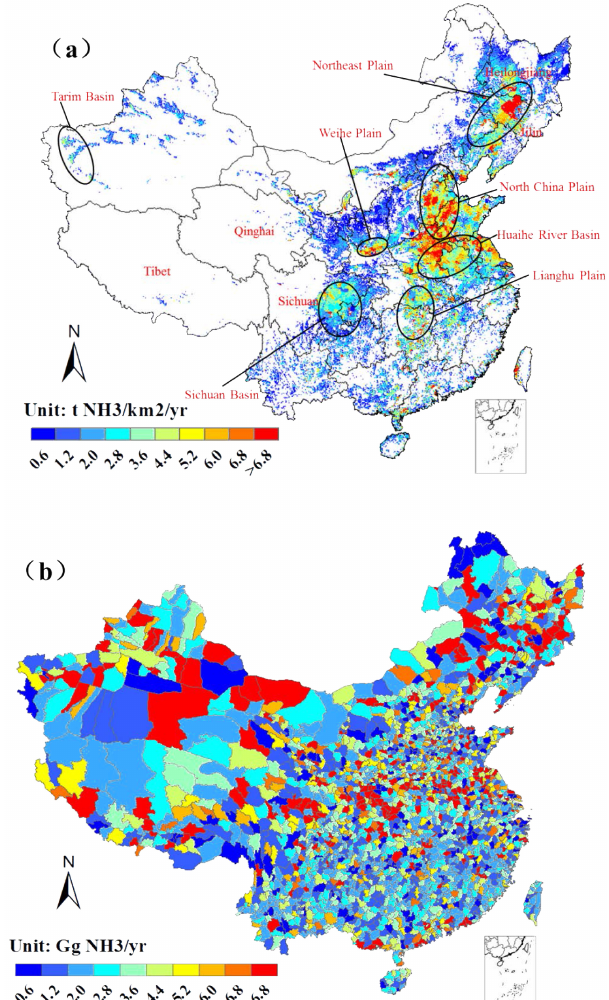
Figure 2. NH 3 emission map of China’s agricultural fertilizer at 1km × 1km (a) and the county level (b) for 2008. Major emission areas are circled.